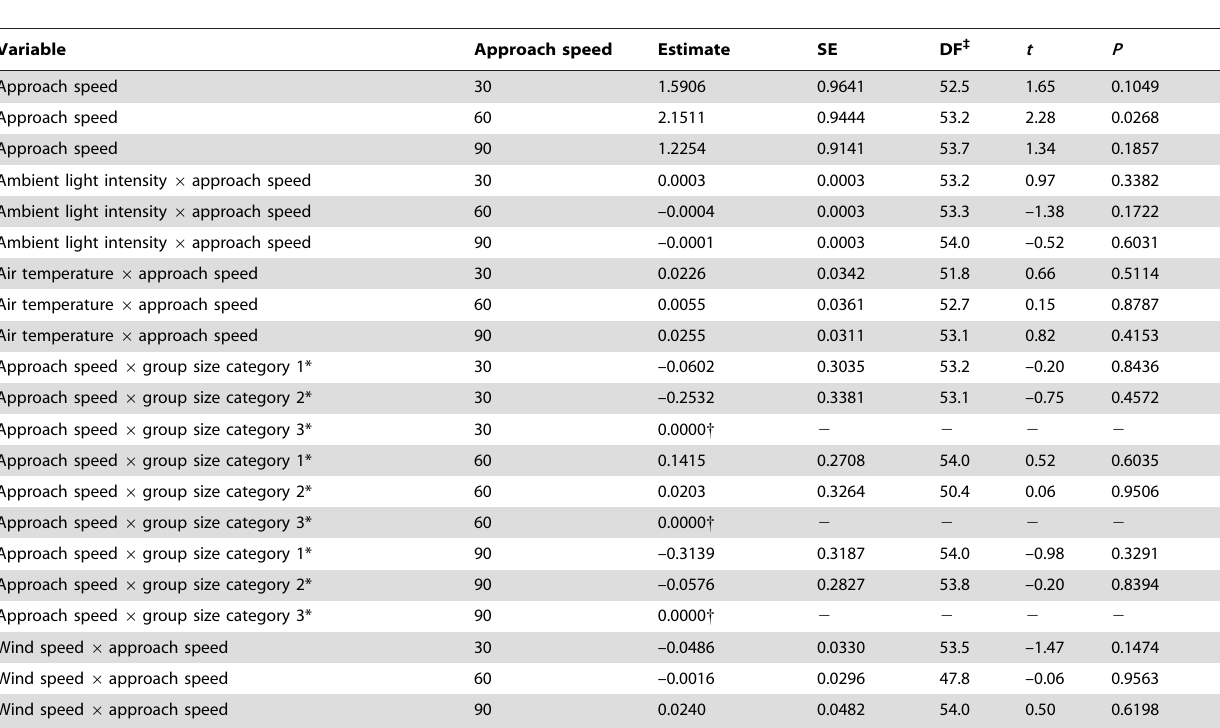
Table 5. Results from a mixed linear model, repeated-measures analysis of time-to-collision (TTC) for groups of free-ranging turkey vultures exposed to the approach of a Ford F250 pickup truck from a standard 1.13-km distance at 30 kph (n=25 approaches), 60 kph (n=25 approaches, but only 24 considered because of a missing value), or 90 kph (n=23